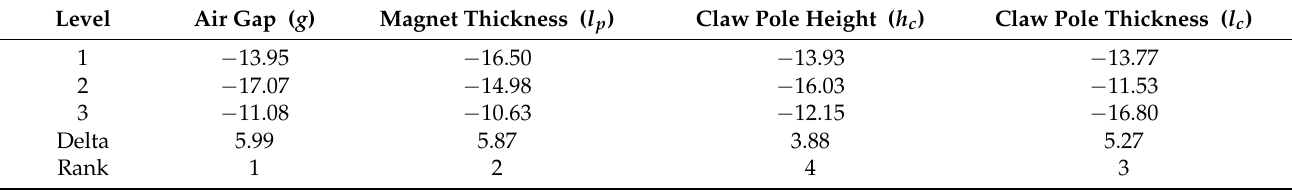
Table 4. SNR response table of detent torque.